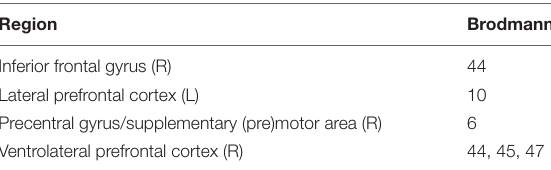
TABLE 2 | Characteristics of resilience-specific clusters of the salience network (SN). Region Brodmann area Voxel size Peak of activation (voxel) X, Y, Z P- value Inferior frontal gyrus (R) 44 10 68, 18, 48 0.025 Lateral prefrontal cortex (L) 10 29 87, 62, 53 0.019 Precentral gyrus/supplementary (pre)motor area (R) 6 118 67, 15, 42 0.025 Ventrolateral prefrontal cortex (R) 44, 45, 47 269 66, 21, 38 0.046 The size of the clusters is given using a threshold of 0.05.L, left; R, Right.